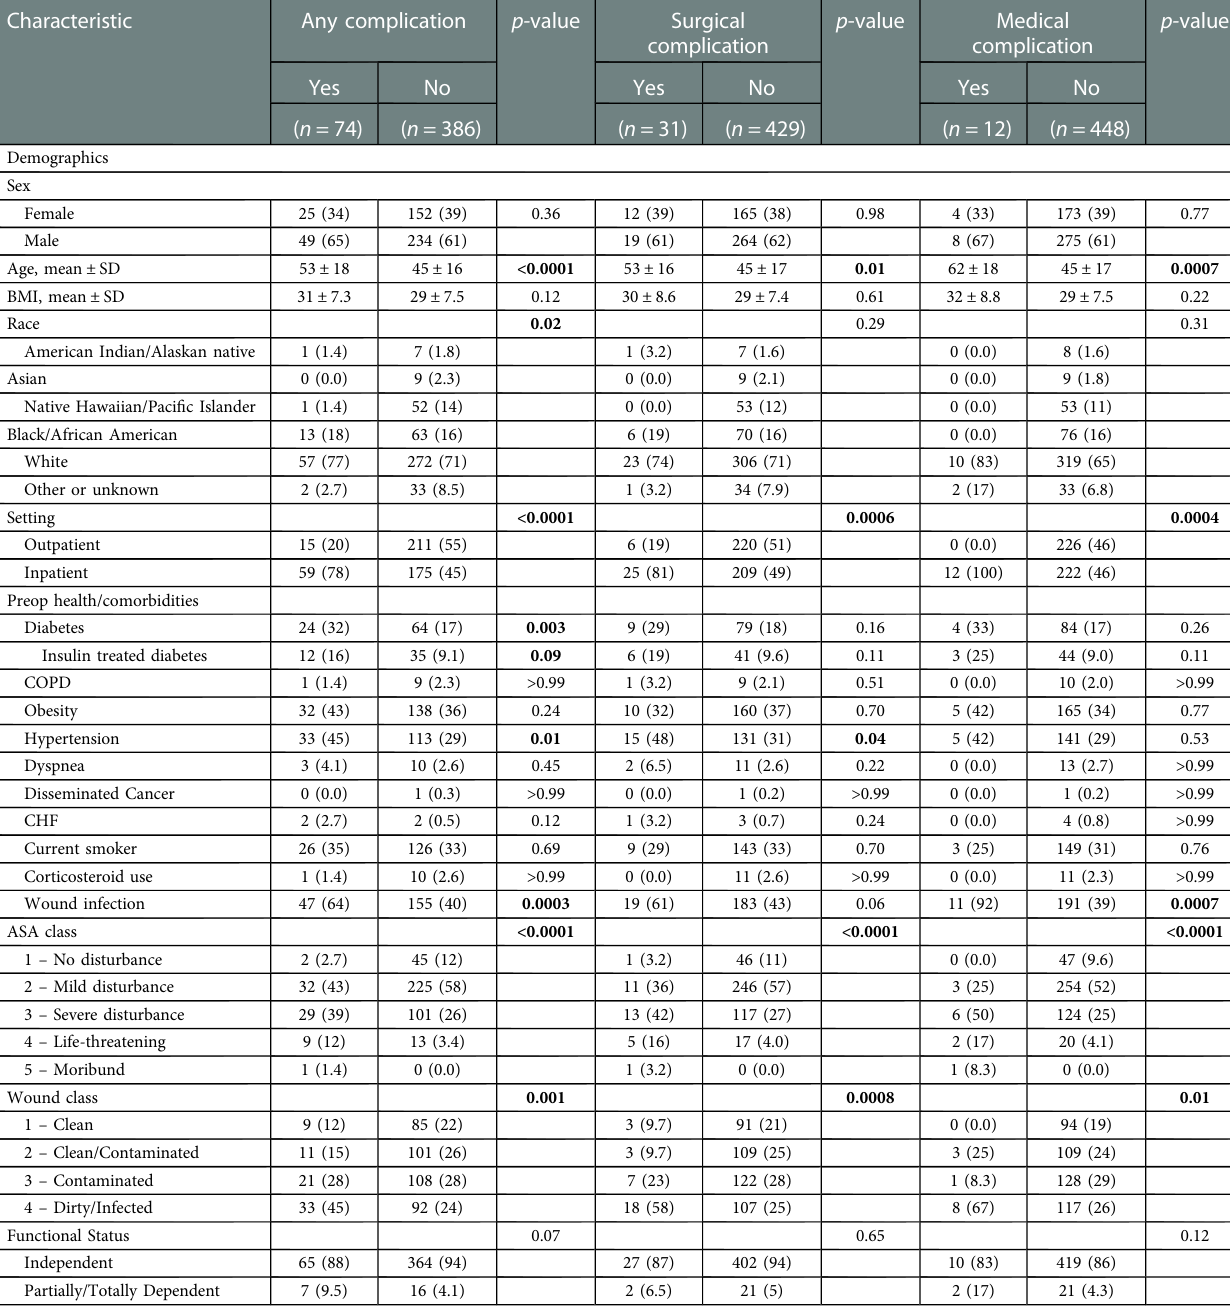
TABLE 4 Risk factors for complications. Reported as n (%), unless otherwise stated.